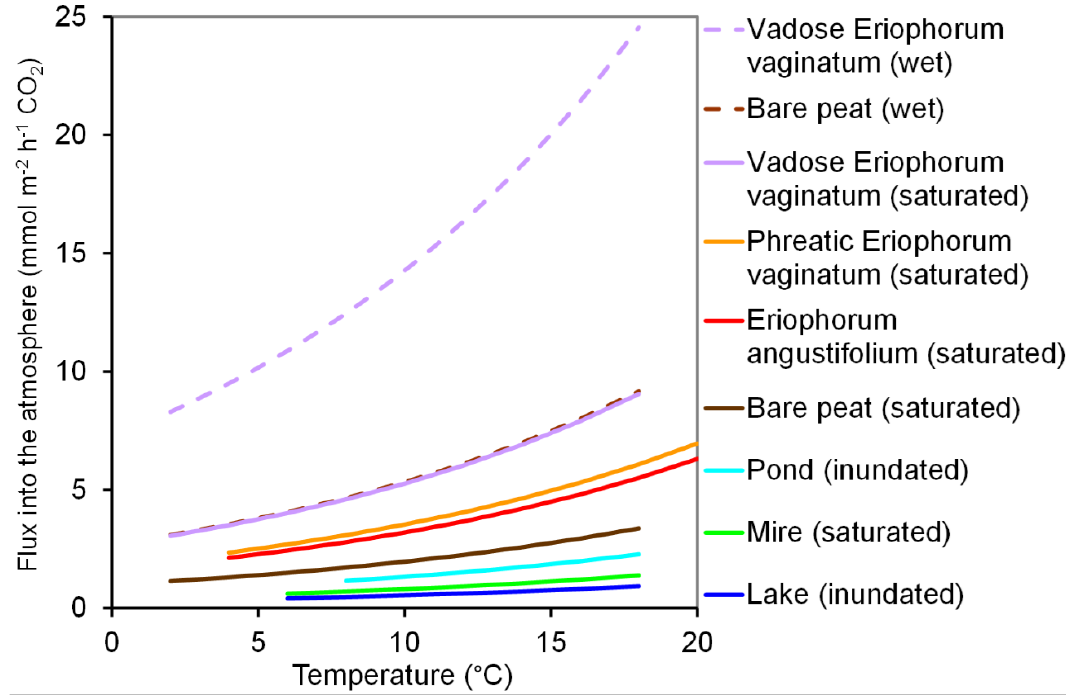
Figure 3. Ecotope CO 2 fluxes to the atmosphere (mmol m -2 h -1 ) related to soil/water temperature (°C) and soil water conditions. Fluxes estimated with the linear mixed effects model (Table 5) based on measured temperature